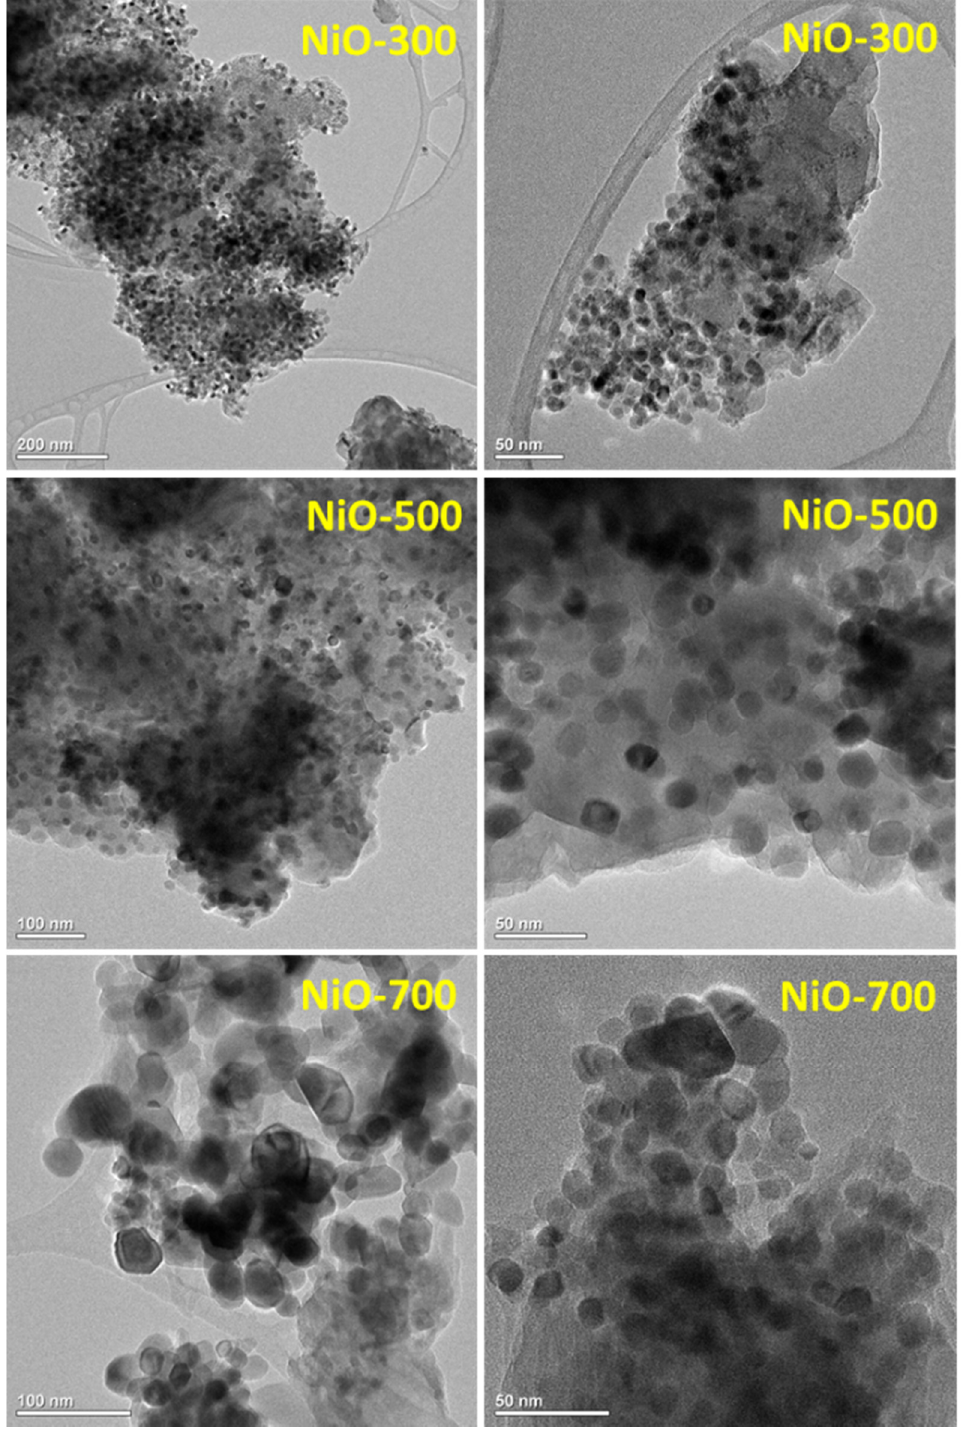
Figure 4. TEM images of the different NiO